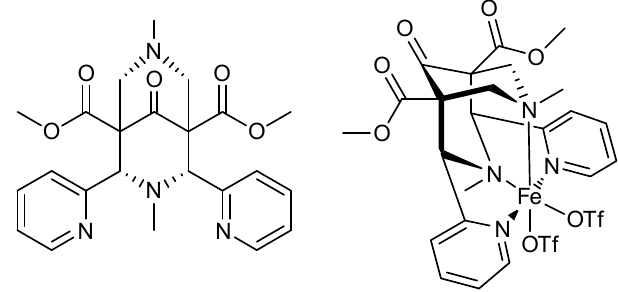
Figure 1. Structure of the bispidine N 2 Py 2 ligand (left) and geom- etry of the [Fe II ( N 2 Py 2 )( OTf ) 2 ] complex